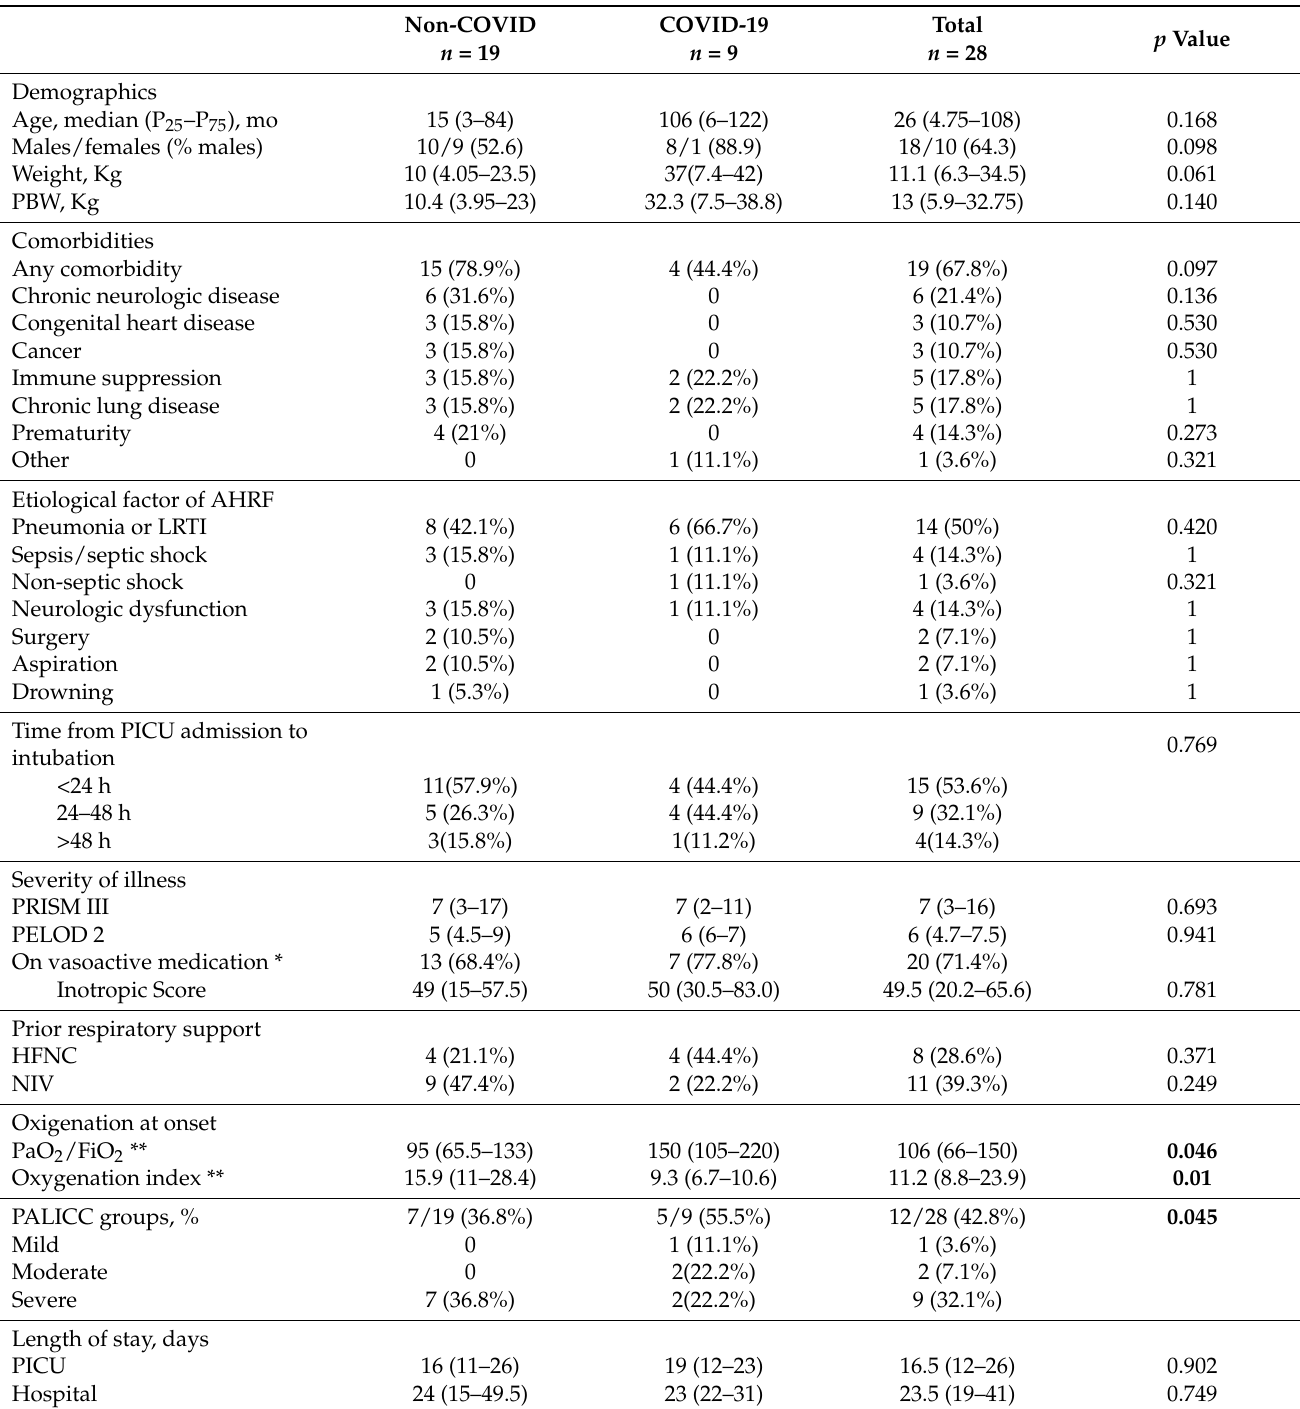
Table 1. Demographics and general clinical data from 28 patients with acute respiratory hypoxemic failure receiving invasive mechanical ventilation. Patients were stratified by COVID-19